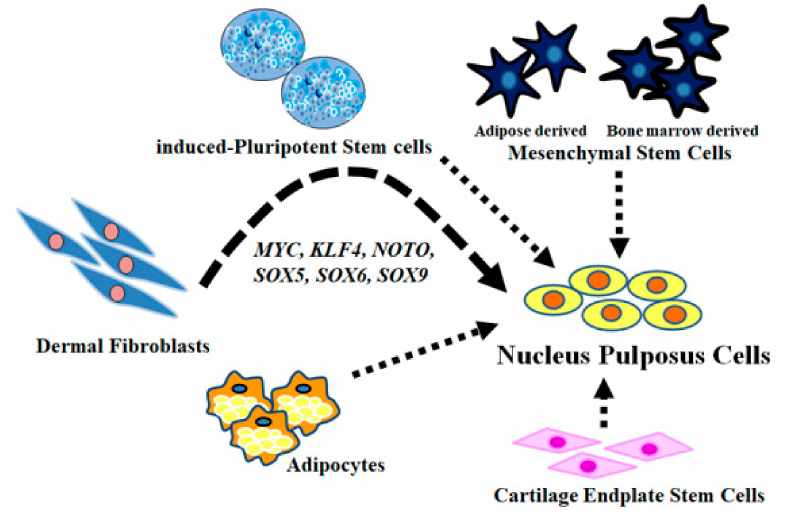
Figure 7. Potential targets of cell